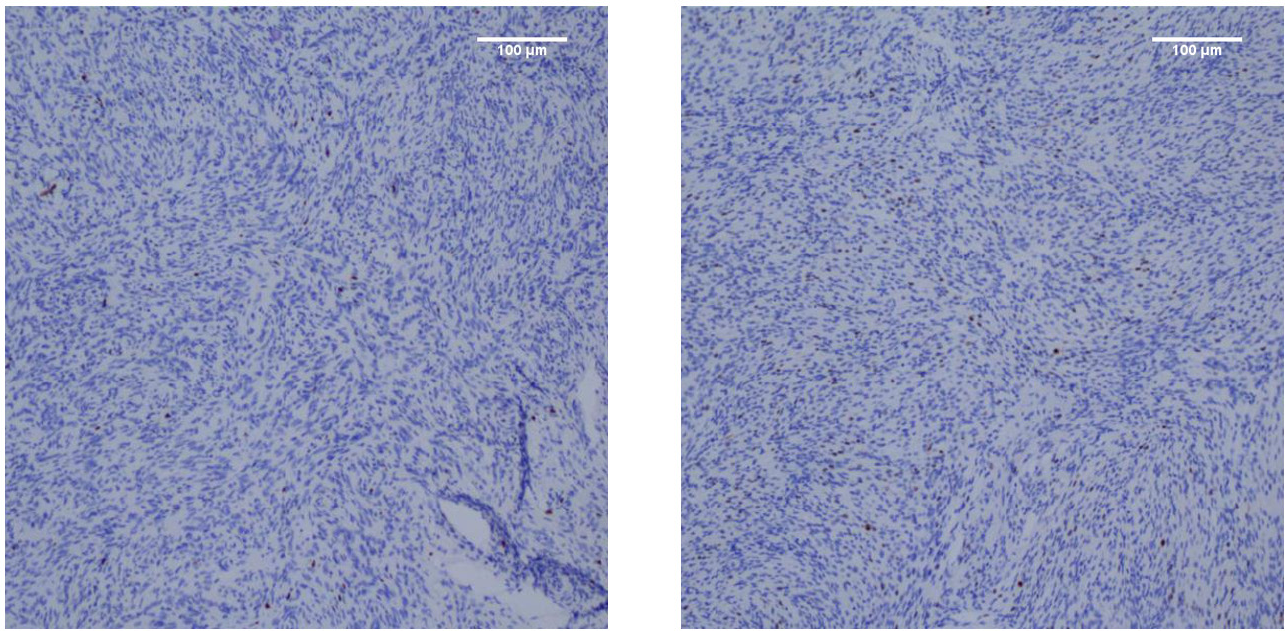
Figure 2. Immunohistochemical staining for Ki-67 in meningiomas.